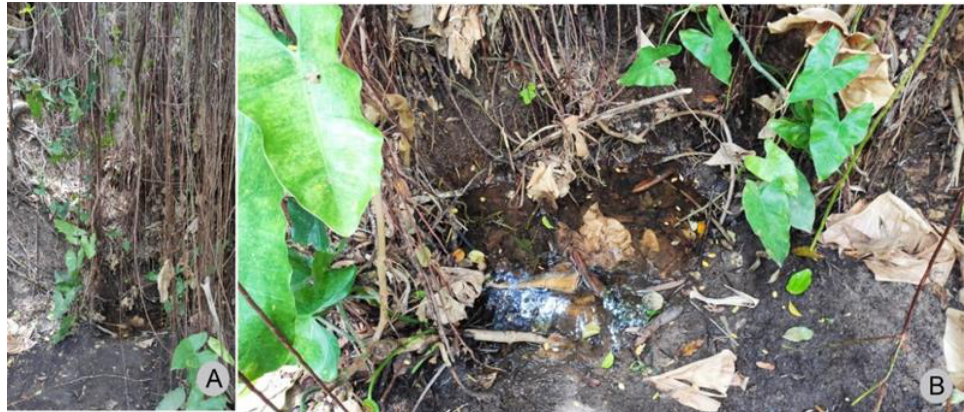
Figure 5. Photographs of the spring where Paravelia luisi sp. nov. was collected. ( A ). Distant view, showing the environment around the spring. ( B ). Close up view.